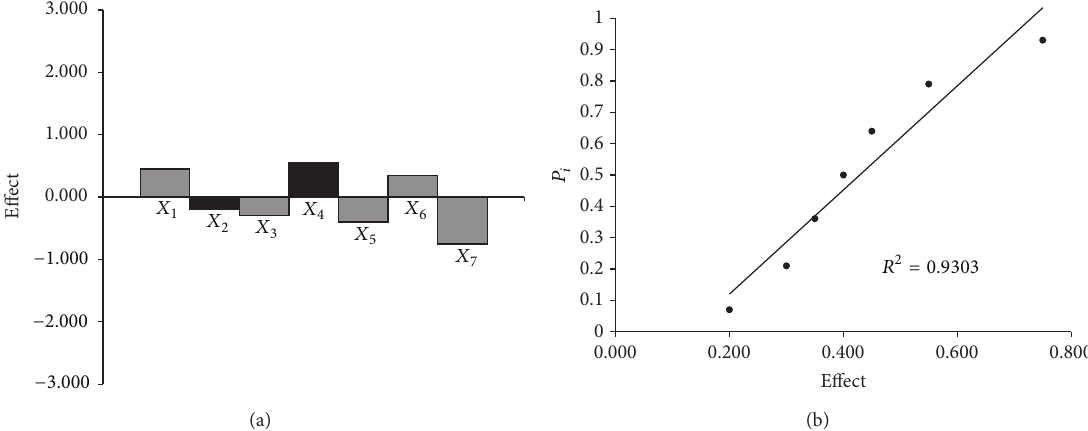
Figure 5: Robustness test: the effect of the factors (a) and half-normal probability plot of effects (b) for determination of lidocaine hydrochloride in examined